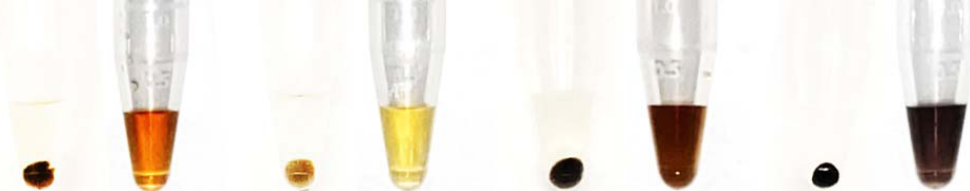
Figure 2. Images of isolated melanins showing two fractions: spin-down melanosomes (left-hand tubes) and supernatants of melanin nanoaggregates (right-hand tubes).